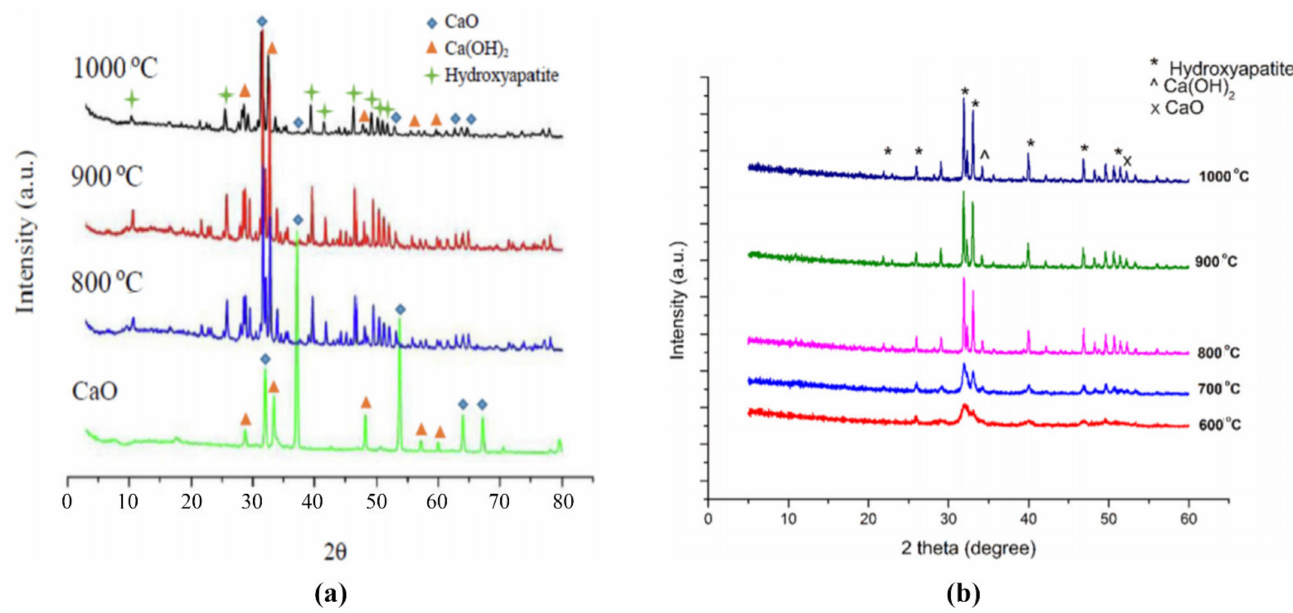
Figure 3. XRD analysis ( a ) fusion of chicken and fish bone, ( b ) ostrich